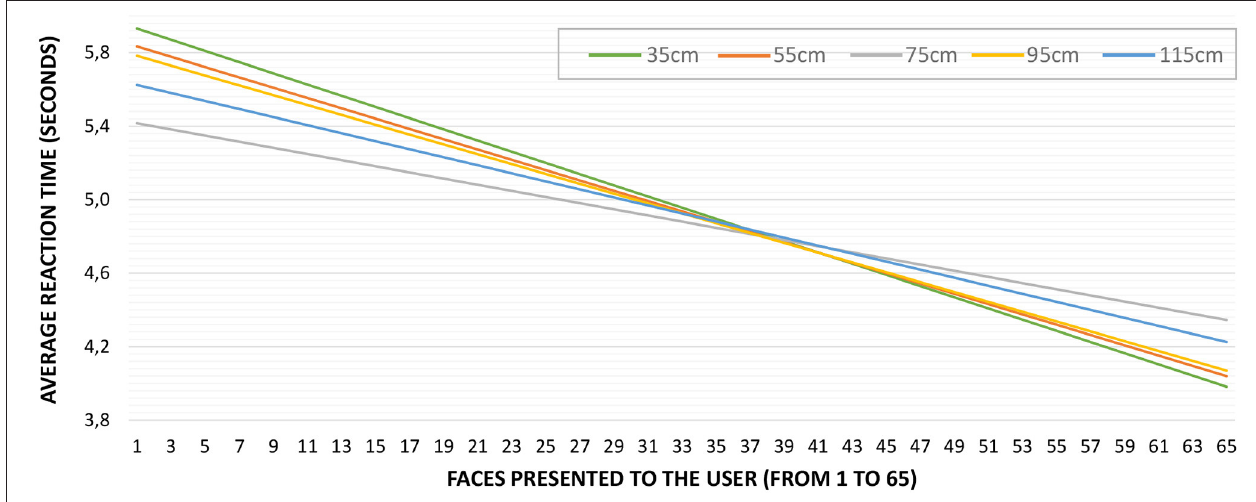
FIGURE 8 | Emotion identification errors per distance. Only trend lines are displayed for clarity. The trend lines show a negative slope between − 3.5 % for D1 (35 cm) and − 1.6 % for D3 (75 cm).